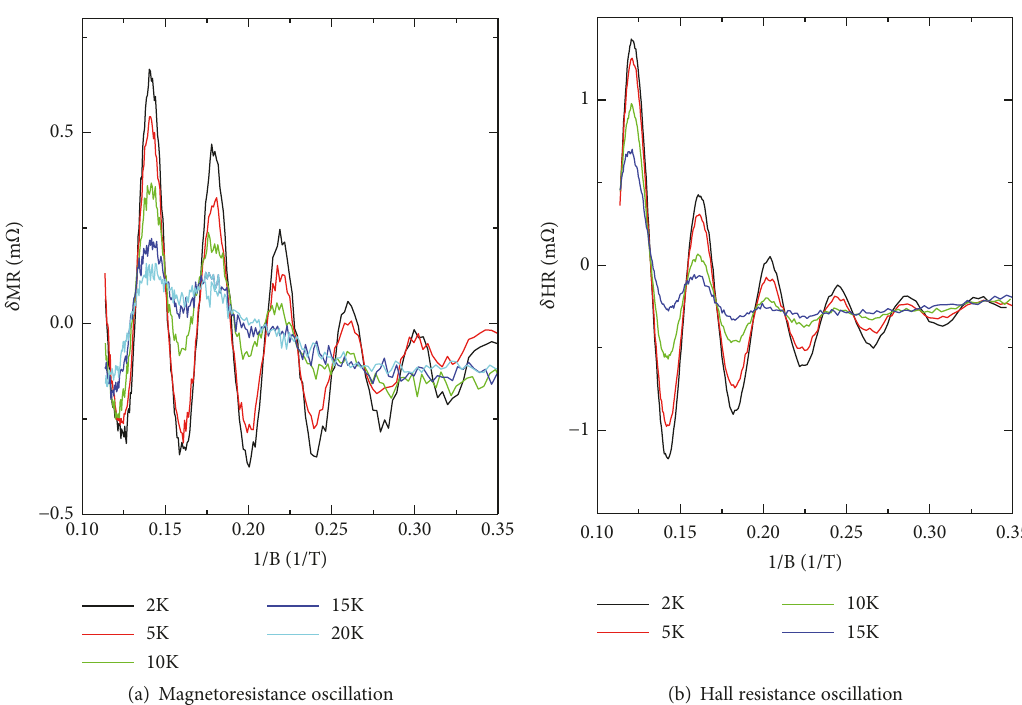
Figure 2: Quantum oscillations in Bi 0.96 Sb 0.04 (a) in the longitudinal magnetoresistance MR and (b) in the Hall resistance HR. Note that the oscillations in MR and HR are in antiphase.